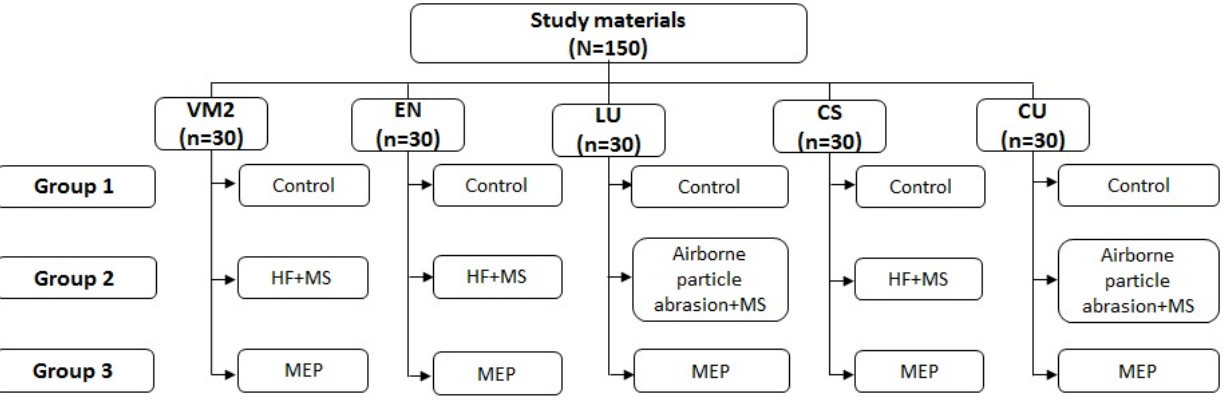
Figure 1. Schematic presentation of the study process and specimen